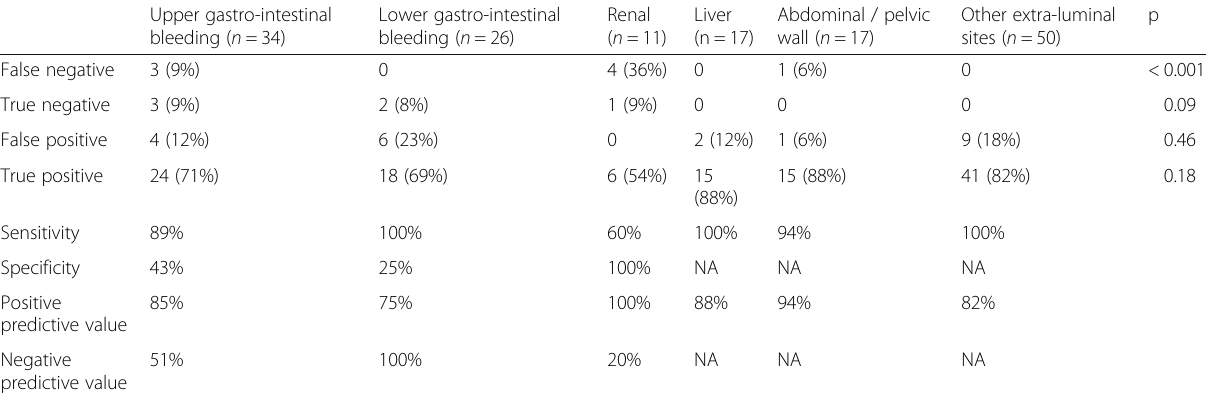
Table 2 CTA studies categorised by true/false positive/negative and bleeding site Upper gastro-intestinal bleeding ( n = 34)